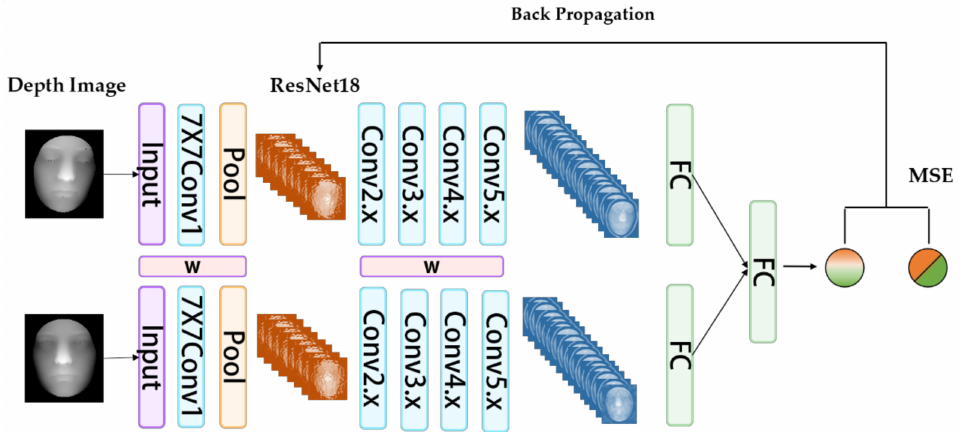
Figure 5. Structure of the transfer Siamese